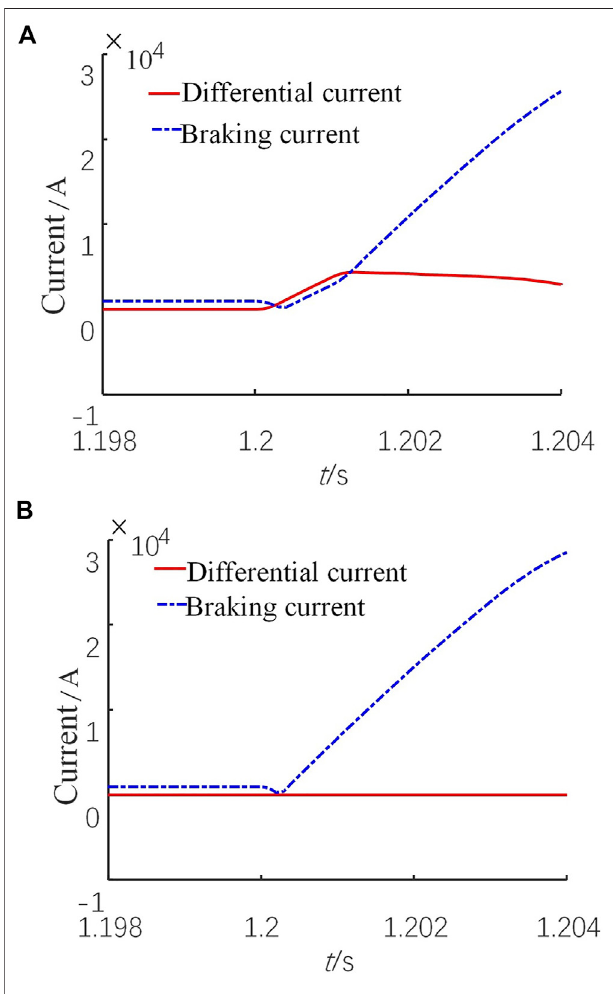
FIGURE 10 | High-frequency current amplitude waveforms under an internal fault without data synchronization (A) PZ I (B) PZ II. FIGURE 11 | Differential current and restraint current waveforms under